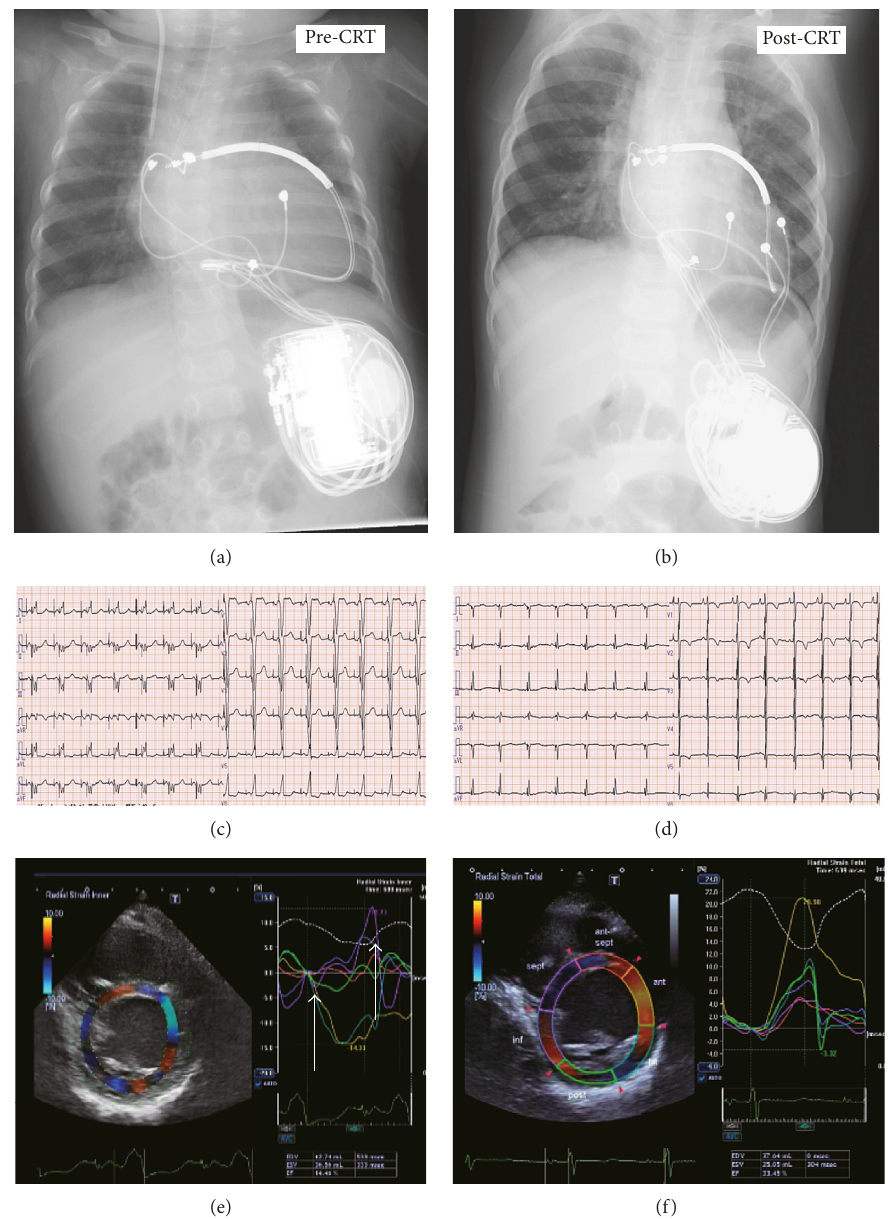
Figure 2: Chest X-rays pre- and postcardiac resynchronization therapy (CRT). (a) The defibrillator was placed into the left upper abdomen, and the shock lead was fixed at the level of the superior vena cava. The right ventricular (RV) epicardial lead was placed at the RV free wall. (b) The left ventricular (LV) lead was placed at the LV lateral wall. The 12-lead ECG pre- and post-CRT. Before CRT (c), the QRS duration was 114msec. After CRT (d), the QRS duration was shortened to 80msec. Speckle-tracking radial dyssynchrony pre- and post-CRT (Artida ™ ; Toshiba Medical Systems, Tokyo, Japan). Pre-CRT (e), dyssynchrony is shown as a time difference (arrow) between time to peak strain in the anterior wall (yellow) and septum peak strain (purple) (dual chamber (DDD) 90–150bpm with an atrioventricular (AV) delay of 130msec). Post-CRT (C-II), dyssynchrony disappeared (DDD 80–160 bpm, with an AV delay of 120msec and a LV-RV delay of